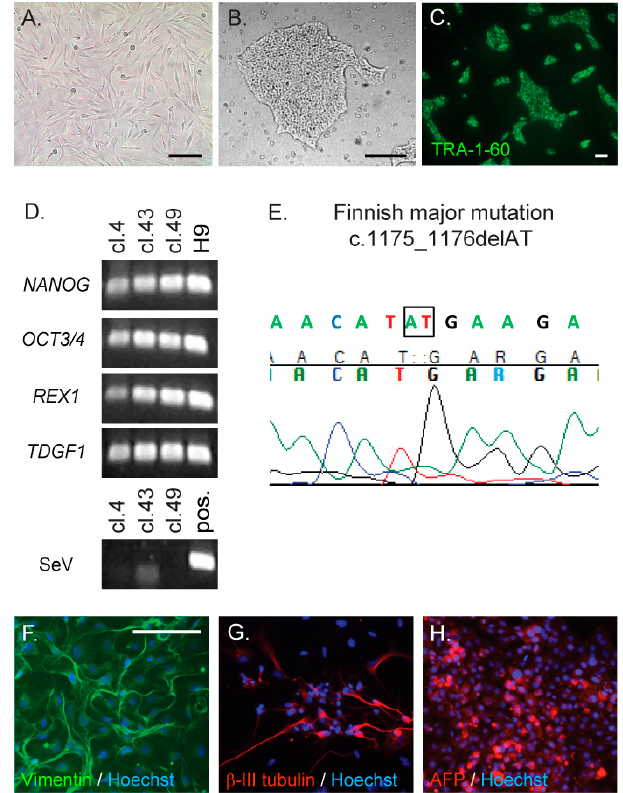
Figure 1. Generation and characterisation of iPS cell lines derived from the CLN5 (ceroid lipofuscinosis, neuronal, 5) patient’s fibroblasts. The CLN5 patient’s fibroblasts ( A ) were reprogrammed to induce pluripotent stem cells (iPSCs) using a Sendai virus-mediated delivery of the four Yamanaka factors. CLN5Y392X iPSC clones were collected on the basis of colony morphology ( B , a representative image shown); and the colonies were stained for TRA-1-60, a specific stem cell marker ( C , shown for one representative clone); RT-PCR was used to detect the expression of endogenous stem cell marker genes, NANOG , OCT3/4 , REX1 and TDGF1 , and the loss of virus expression confirmed by using primers specific for Sendai virus (SeV) ( D , shown for the three characterised CLN5Y392X iPSC clones (cl.) and a positive control hES cell line, H9. Sendai virus-infected fibroblasts were used as a positive control (pos.) in analysis of Sendai viral expression); The presence of the original CLN5 disease causing mutation in each analysed CLN5Y392X iPSC clone was confirmed by sequencing ( E , illustrated from one representative clone, nucleotides in the box represent second and third nucleotides of the codon TAT, and are missing in mutated DNA); Pluripotency of the three characterised CLN5Y392X iPSC lines was verified by their ability to differentiate into the three germ layers, mesoderm, ectoderm and endoderm, detected by staining with vimentin ( F ), β -III tubulin ( G ) and α -fetoprotein (AFP, H ) antibodies, respectively (shown for one representative clone with nuclear staining shown in blue); Bar 100 µm ( A , F – H ), 300 µm ( B ) and 50 µm ( C ).